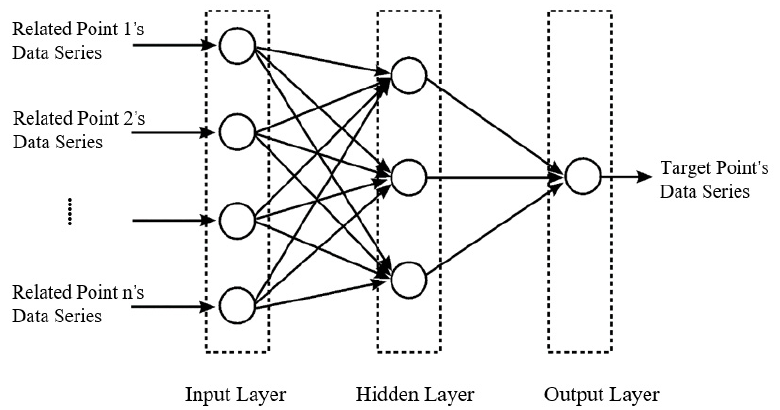
Figure 3. Schematic diagram of BP neural network structure.